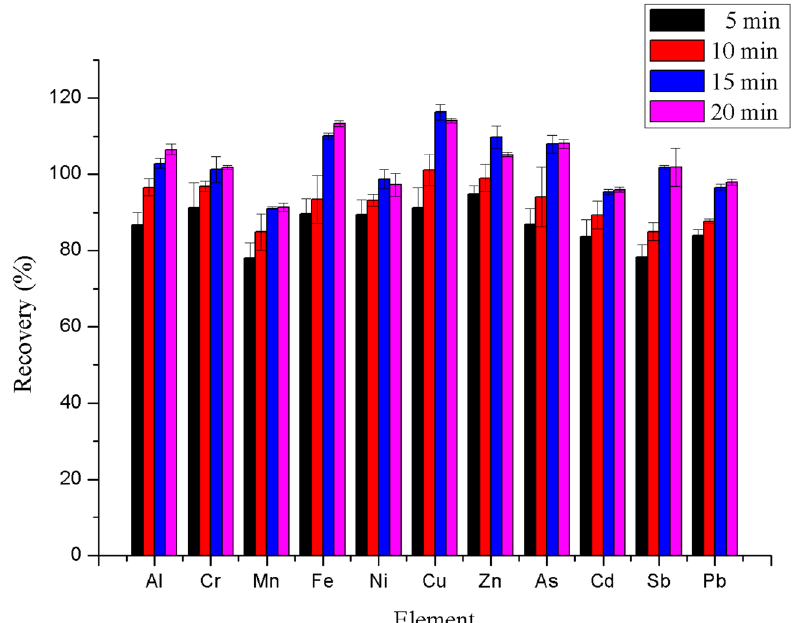
Figure 4: E ff ect of di ff erent digestion times on the recovery of each